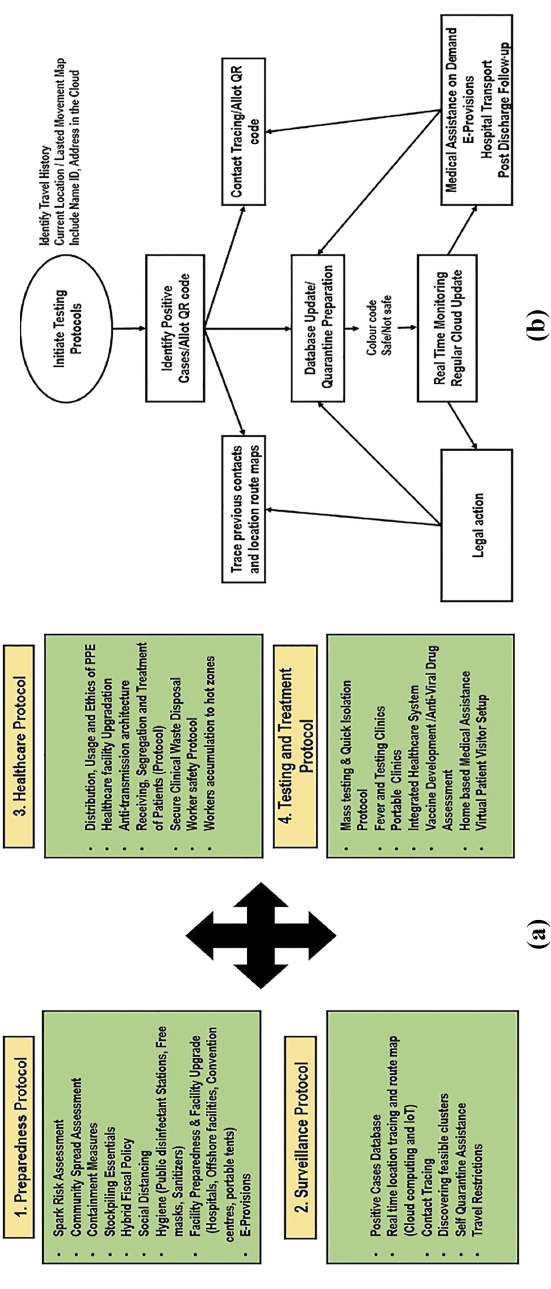
Figure 5. Conceptual frameworks on strategic